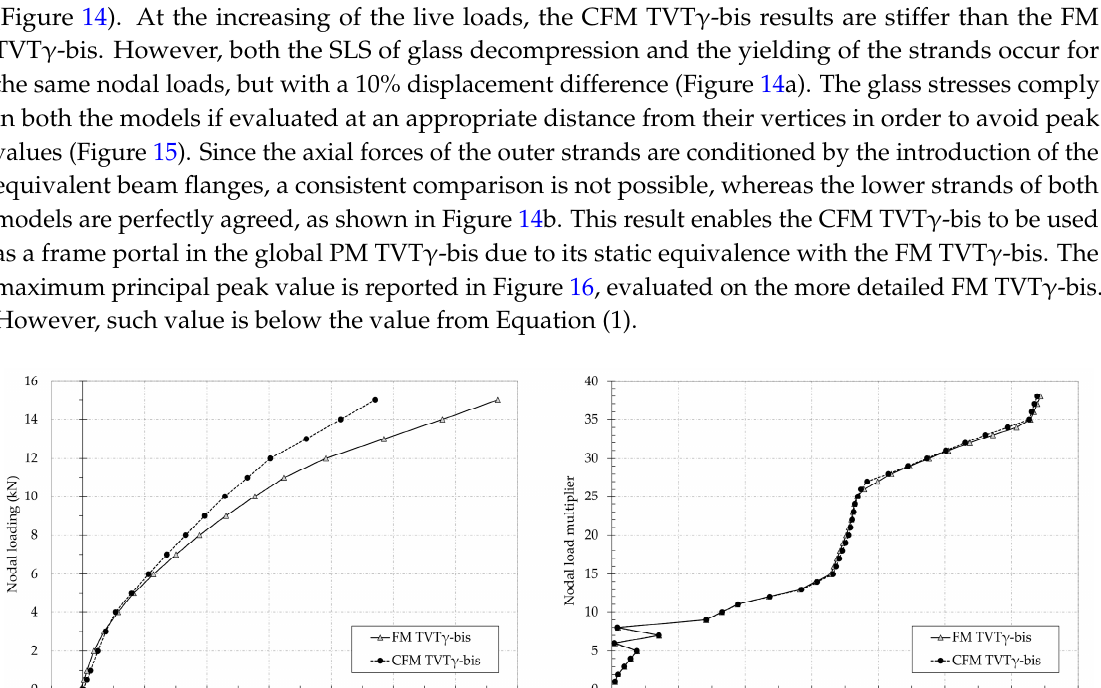
( d ) Figure 15. ULS non ‐ linear static analysis and comparison between FM TVT γ‐ bis (first row) and CFM TVT γ‐ bis (second row): ( a, c ) maximum principal stress; ( b, d ) minimum principal stress. Figure 16. Details of the maximum principal stress in the FM TVT γ‐ bis. The peak value is below the strength of glass from Equation (1).